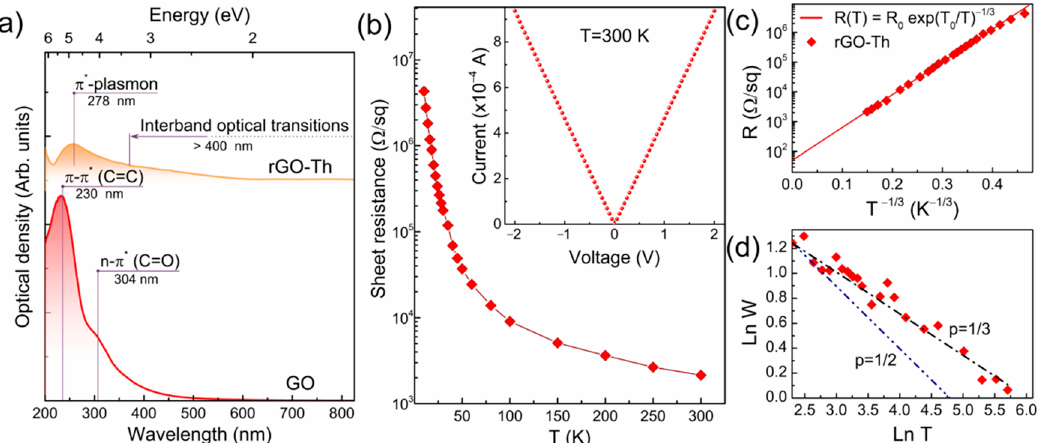
Figure 4. Optical and electrophysical properties of rGO–Th. ( a ) UV-vis spectra of the initial GO and rGO–Th. ( b ) Semi-log scaled plot of resistance versus a temperature. Insert—the I–V curve measured at T = 300 K. ( c ) The resistivity ln R versus T − 1/3 plot. The symbols are the experimental points, and the solid line is a fit to T − 1/3 approximation. ( d ) Reduced activation energy (W) plotted versus a temperature (T) in a log–log scale; the lines corresponding to p = 1/2 and p = 1/3 are displayed as a comparative guide for eyes.